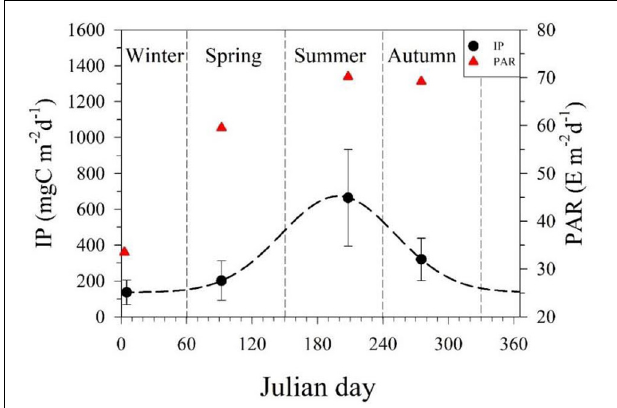
FIGURE 9 | Annual variations in the averaged seasonal euphotic zone integrated primary production (IP) of the CYR. The error indicates one standard deviation of the mean. The dashed line represents the fitted left-skewed normal distribution curve of IP in